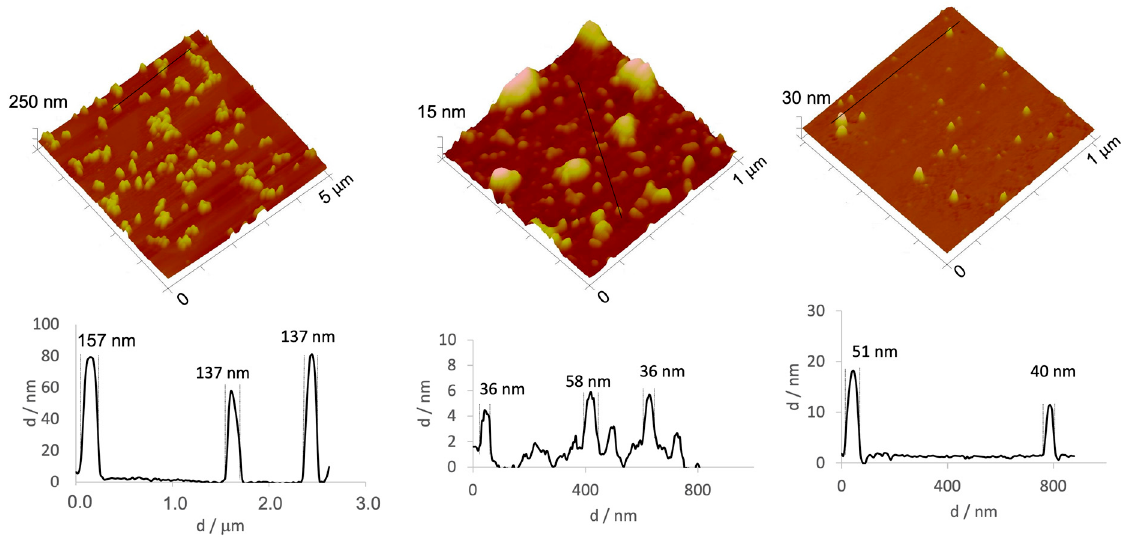
Figure 2. 3D atomic force microscopy (AFM) images and corresponding profiles for AgNPs prepared following ( left ) method A, ( middle ) method B and ( right ) method